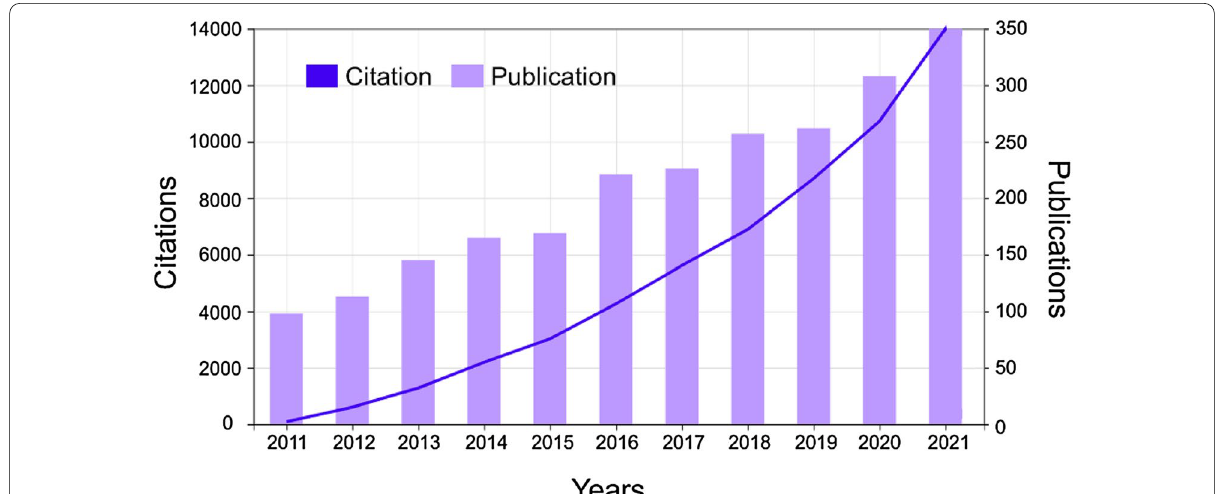
Fig. 1 The number of annual citations and publications from 2011 to 2021. Searches were carried out with Web of Science using the keyword: chiral nanomaterials